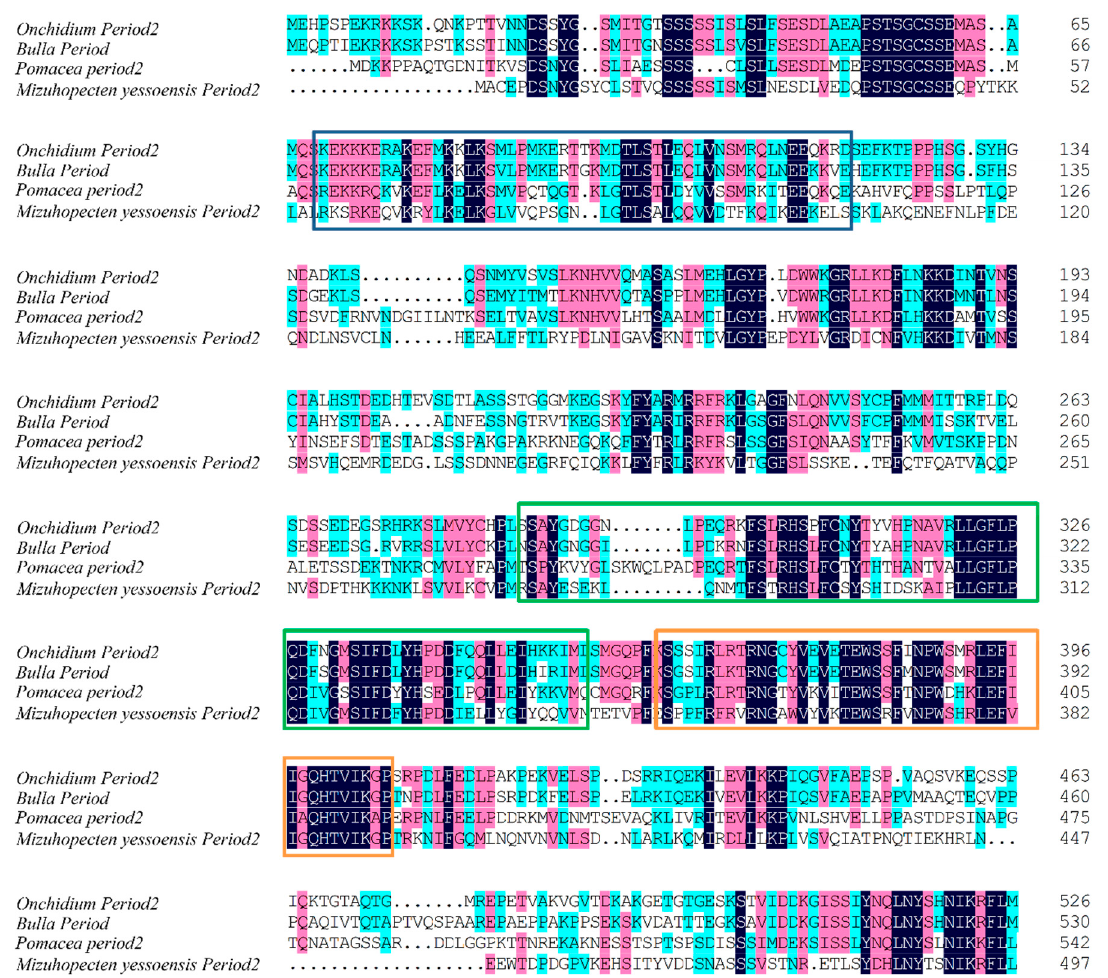
Figure 5. Alignment of conserved regions for PERIOD2. The Onchidium PERIOD2 protein contained conserved domains present in orthologs for Bulla, Pomacea, and Mizuhopecten: blue frame indicates the HLH domain, green frame indicates the PAS domain and orange frame indicates the PAC binding domain. The blue shading indicates identical residue, a pink shading indicated residue with strongly similar properties, and the cyan shading indicates residues with weakly similar properties.